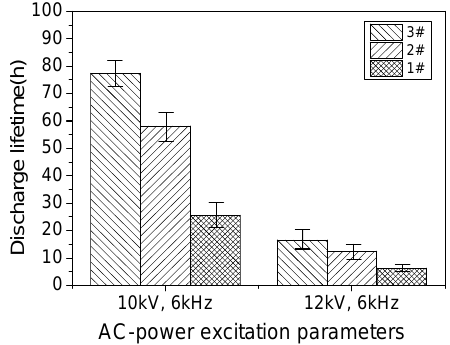
Figure 6. Dielectric lifetime of SDBD plasma devices with different dielectrics under the conditions of the two power supply parameters.